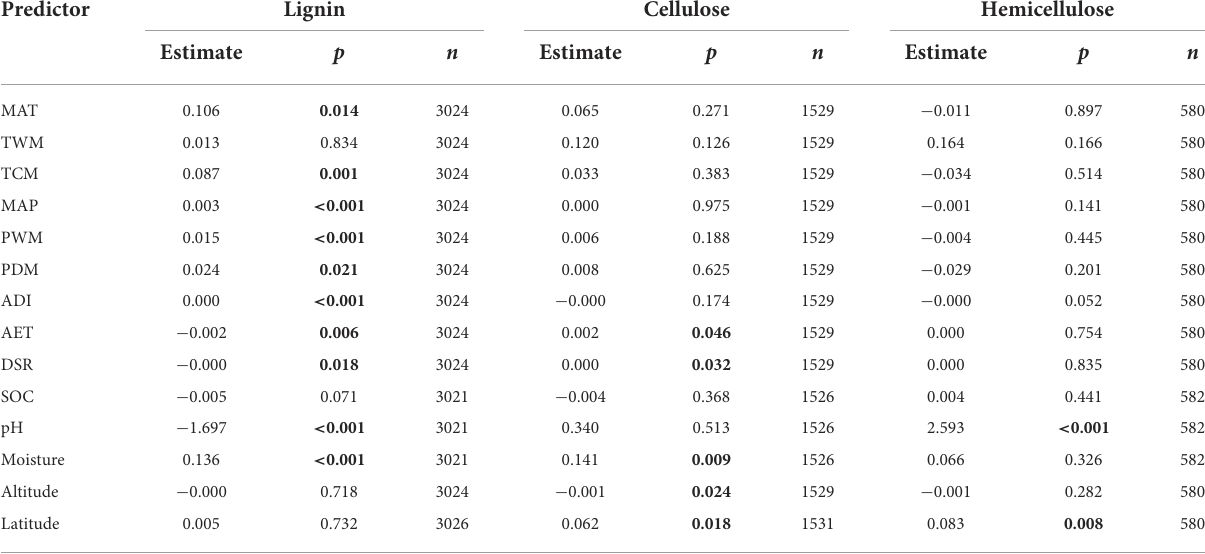
TABLE 1 Effects of climate and soil properties on the initial concentrations of leaf litter lignin, cellulose, and hemicellulose as assessed by linear mixed-effects models.